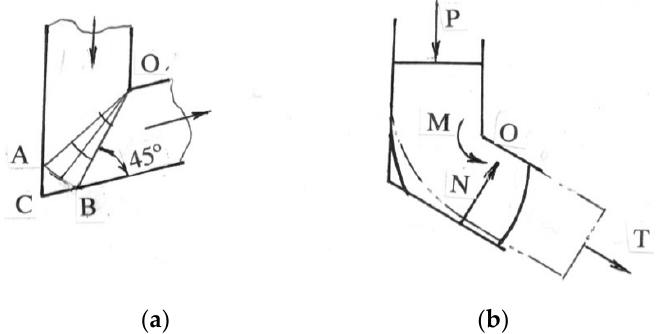
Figure 3. Slip-line field for frictionless ECAE with intersection angles less than 90° ( a ) and material